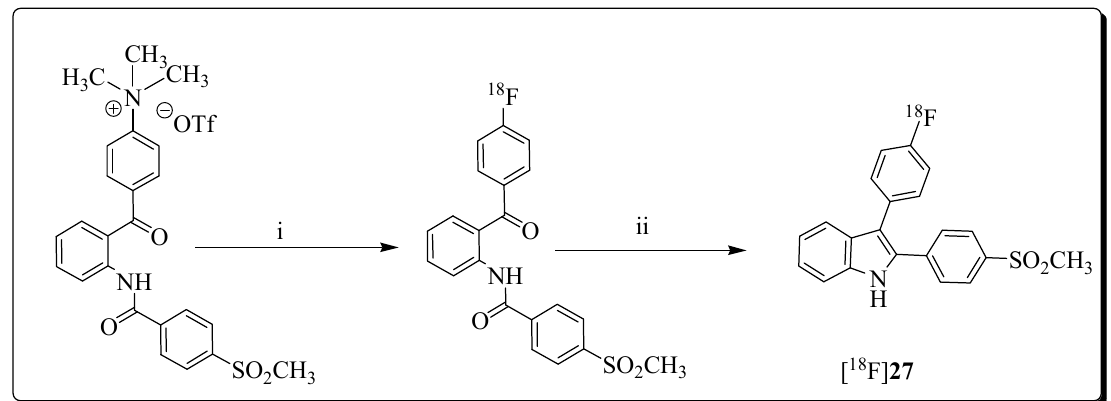
Figure 4. Radiosynthesis of [ 18 F] 27 via McMurry coupling. Reagents: (i) [ 18 F]fluoride, K 222 /K 2 CO 3 , DMF; (ii) TiCl 4 , Zn, THF.